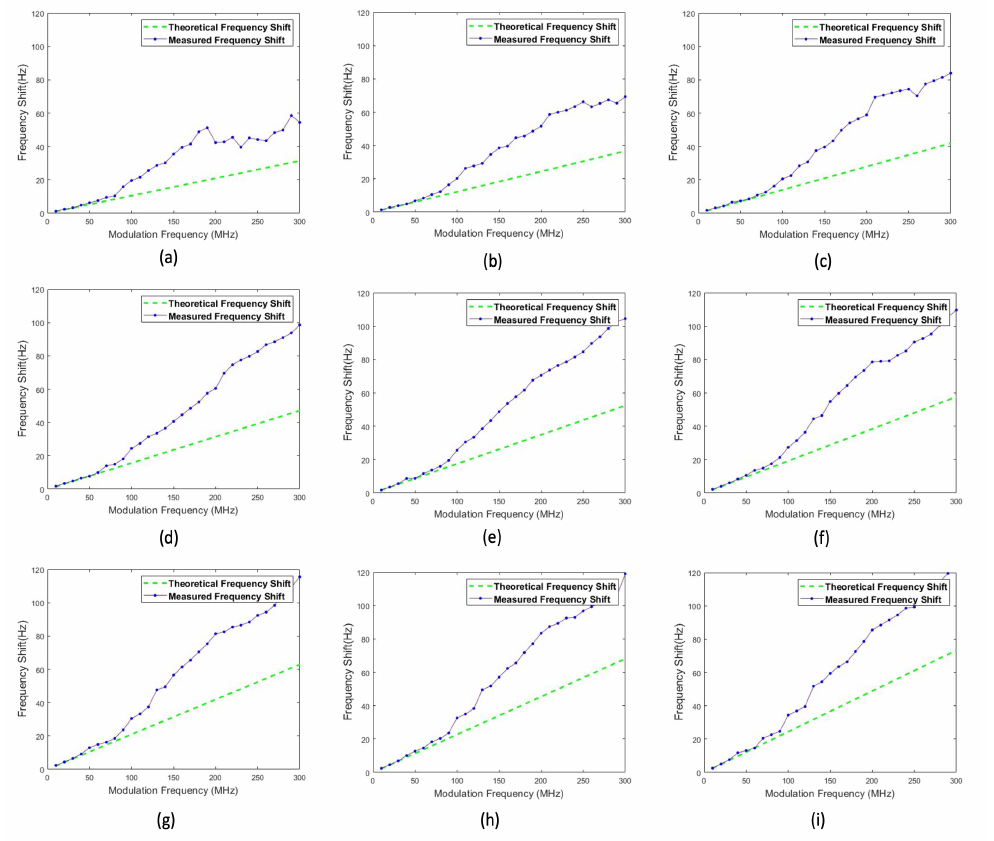
Figure 10. Result of the experiment reported at ( a ) 300 RPM (=linear velocity is 31.416 m/s). ( b ) 350 RPM (=linear velocity is 36.652 m/s). ( c ) 400 RPM (=linear velocity is 41.888 m/s). ( d ) 450 RPM (=linear velocity is 47.124 m/s). ( e ) 500 RPM (=linear velocity is 52.36 m/s). ( f ) 550 RPM (=linear velocity is 57.596 m/s). ( g ) 600 RPM (=linear velocity is 62.832 m/s). ( h ) 650 RPM (=linear velocity is 68.068 m/s). ( i ) 700 RPM (=linear velocity is 73.304 m/s). The green lines denote theoretical shifts and the blue lines denote the measured